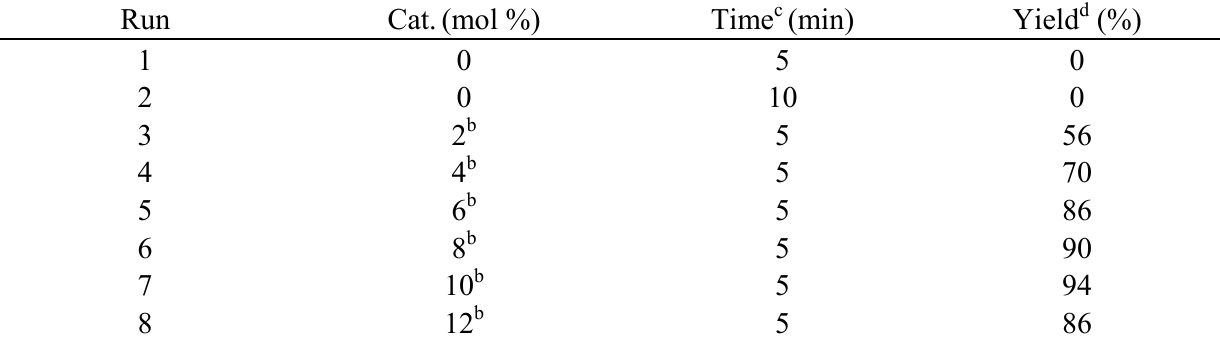
Table 1. Optimization of the catalyst concentration for the synthesis of ethyl ferulate ( 3b ) a